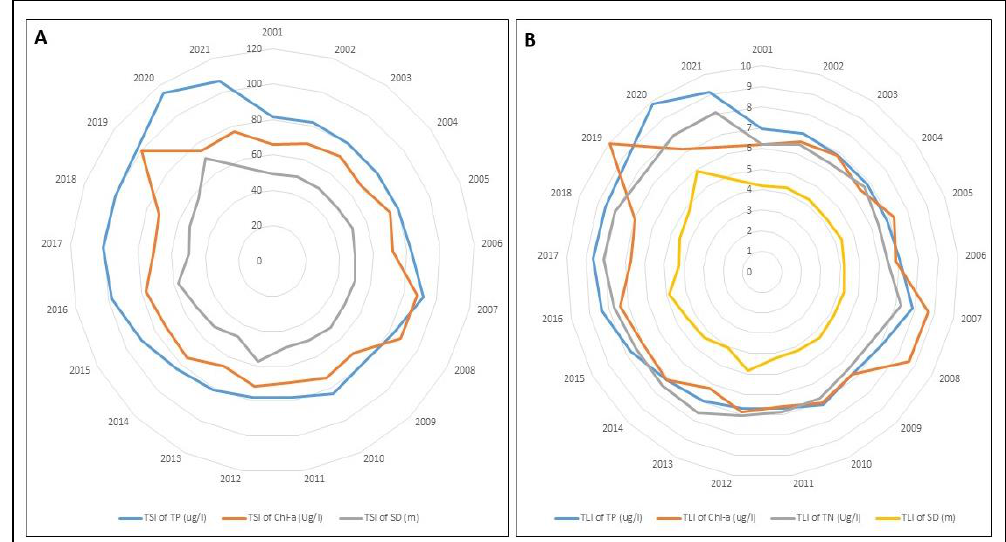
Figure 6. Radar diagram of the nutrient ratio of the Roodeplaat Dam as per ( A ) the Carlson TSI and ( B ) the Trophic Level Index.